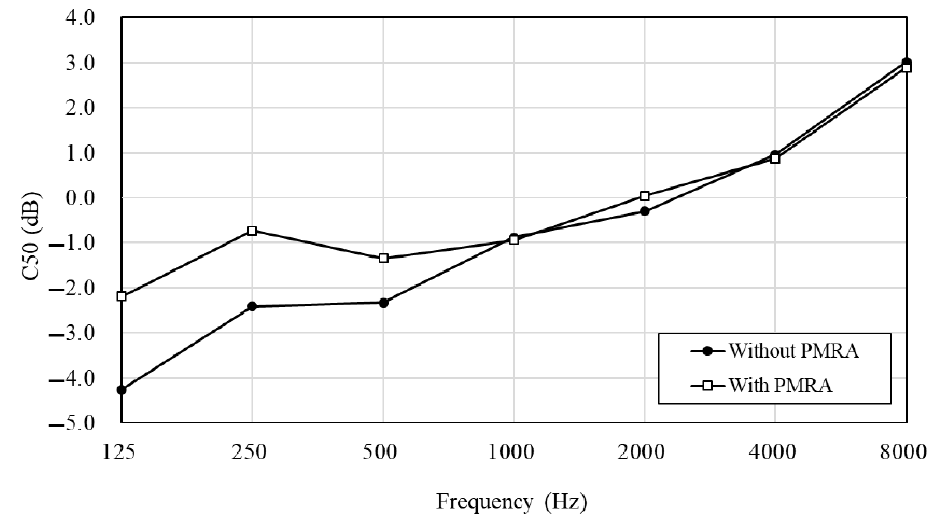
Figure 17. A comparison of C 50 with or without PMRA at each band. Figure 18 shows the comparison of the C 50 with and without the PMRA at 500 Hz. Due to the PMRA installed point, speculated P1 had a long distance with PMRA, and P2 was close to outside noise. Therefore, C 50 had an increased limitation, while the others were significantly increased.